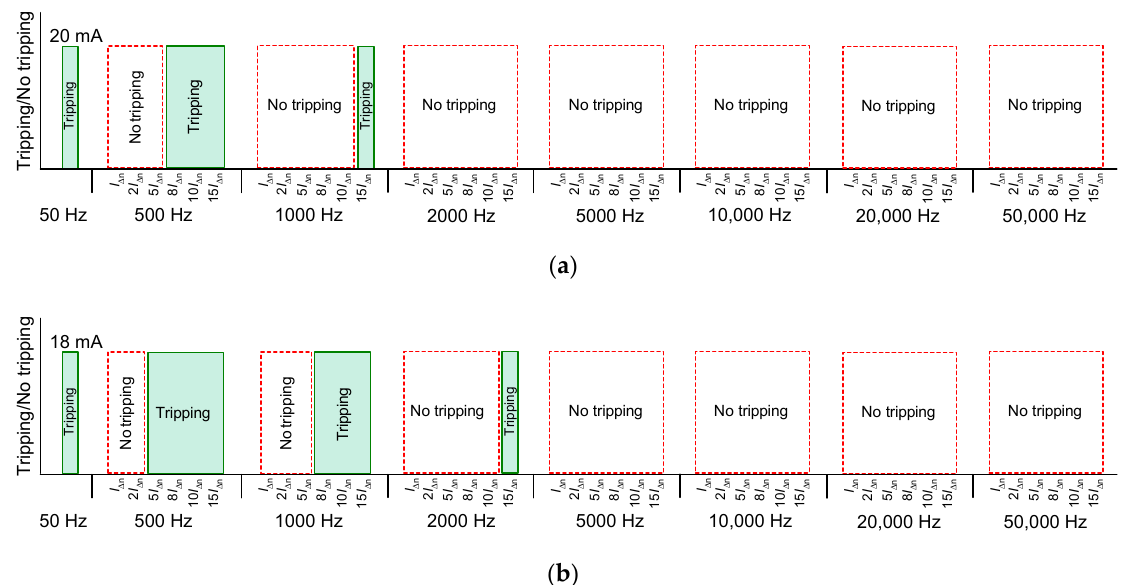
Figure 15. Tripping of the 30 mA F-type RCDs for a sine waveform of the specified frequency from 50 Hz to 50 kHz: ( a ) RCD_1F; ( b ) RCD_2F; symbols defined in Table 2.